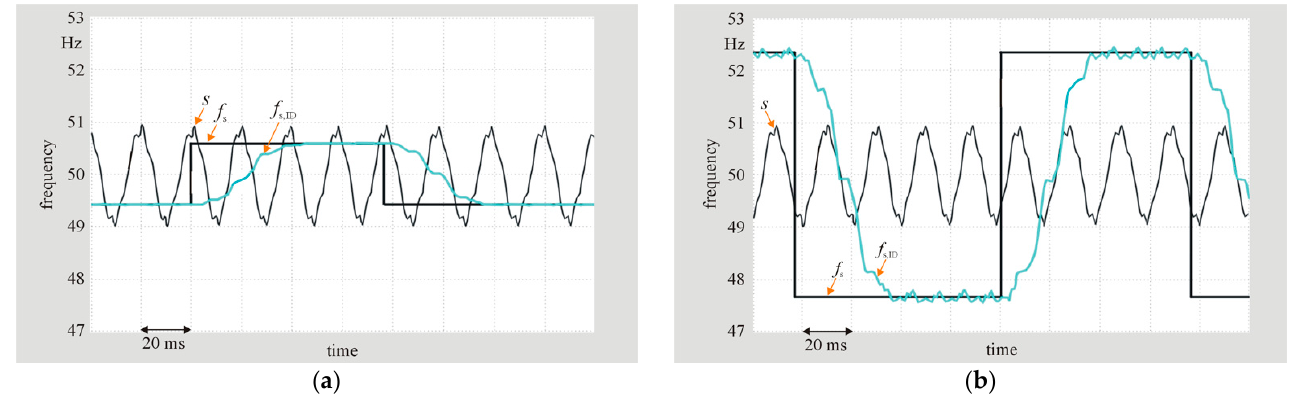
Figure 6. Characteristic signals in the IS when and the input signal is, ( a ) sine wave and ( b ) rectangular.